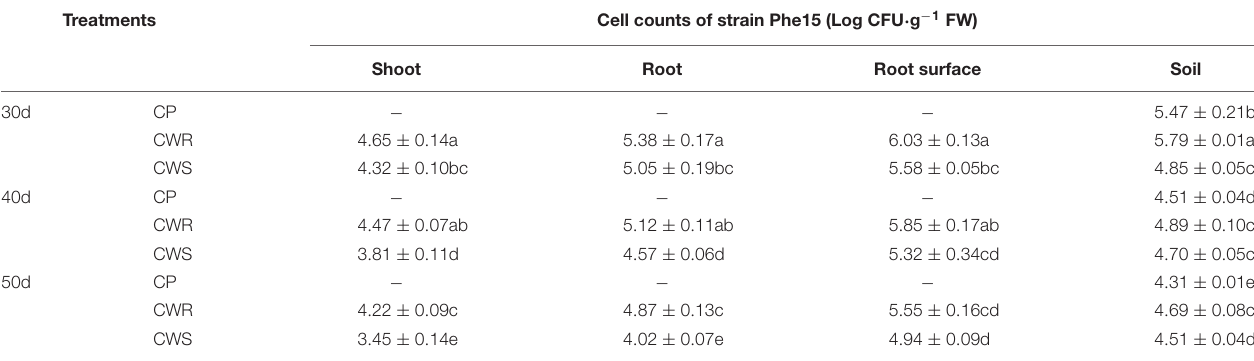
CP, contaminated soil inoculated with strain Phe15; CWR, contaminated soil planted with white clover and inoculated with strain Phe15 via root irrigation; CWS, contaminated soil planted with white clover and inoculated with strain Phe15 via soaked seed; FW, fresh weight; (cid:48)(cid:48) − (cid:48)(cid:48) indicates not detected. Different letters in the same column indicate significant differences (P < 0.05).